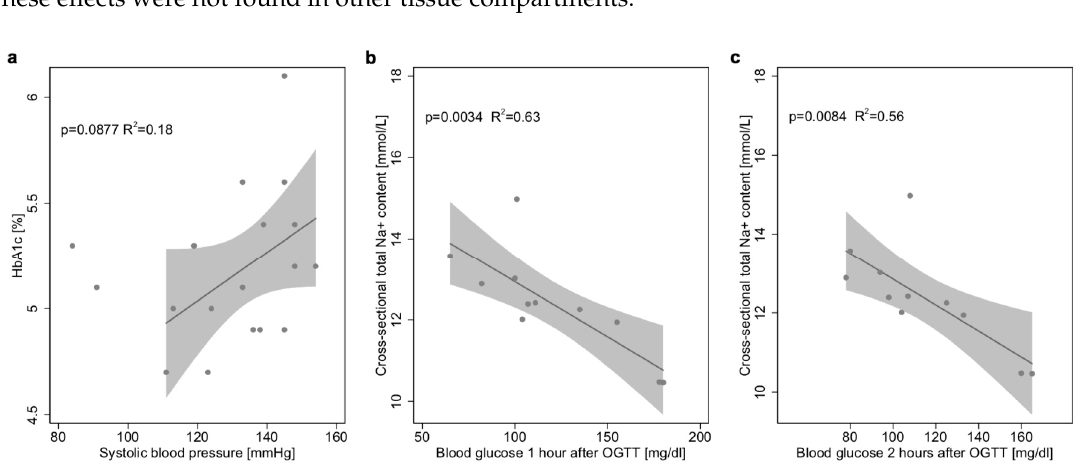
Figure 4. Tissue Na + and glucose metabolism. ( a ) Linear regression model with 95% CI combined with scatter plot, showing no significant correlation between HbA1c and systolic blood pressure (n = 19). ( b ) Linear regression model with 95% CI, combined with scatter plot showing a significant correlation between Na + of the whole leg and blood glucose 1 h after an oral glucose tolerance test (OGTT, p = 0.0034 R 2 = 0.63, n = 11). ( c ) The linear regression model with 95% CI, combined with scatter plot showing a significant correlation between Na + of the whole leg and blood glucose 2 h after an OGTT ( p = 0.0084 R 2 = 0.56, n = 11).